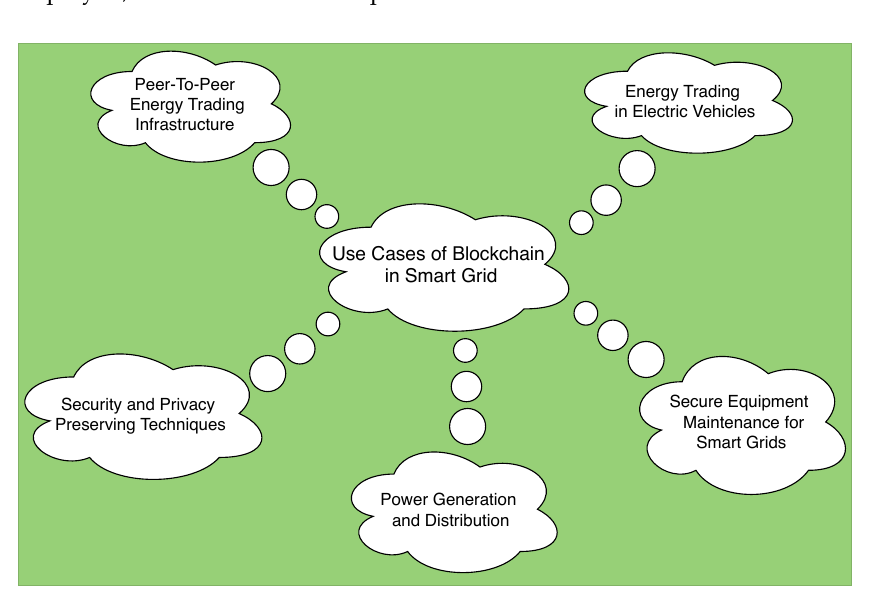
Figure 2. Applications of blockchain in smart